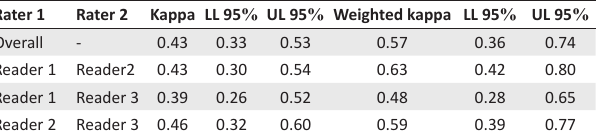
TABLE 4: Inter-observer reliability.